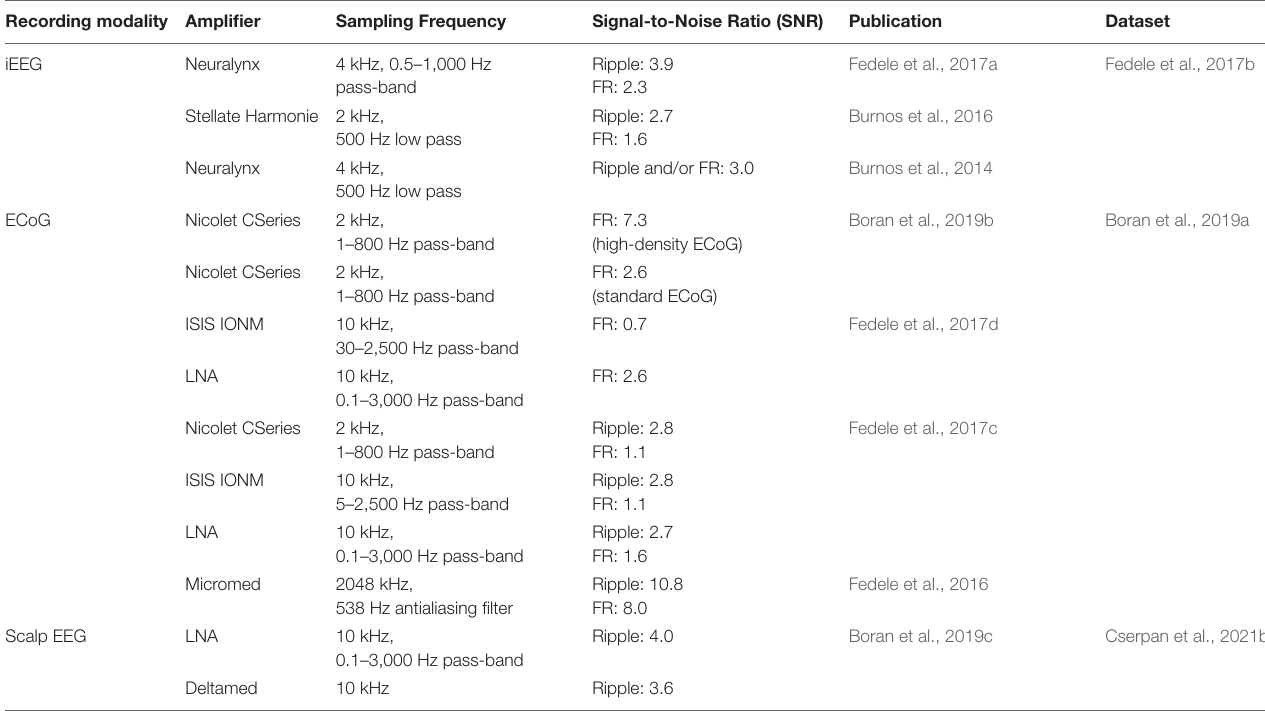
TABLE 4 | Recording setup and SNR of the iEEG, ECoG, and scalp EEG datasets. Recording modality Amplifier Sampling Frequency Signal-to-Noise Ratio